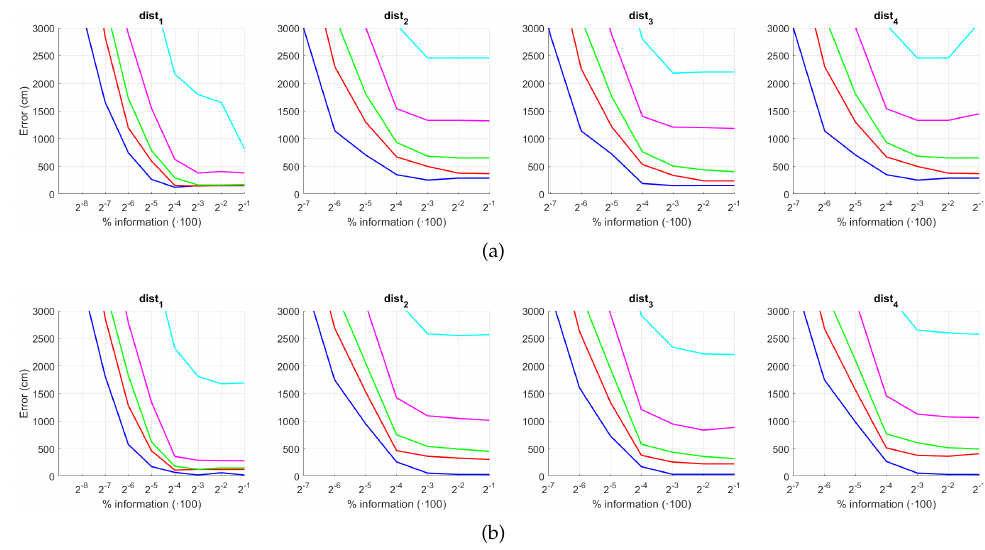
Figure 27. WS average localization error with occlusions: ( a ) no filter and ( b ) homomorphic filtering. Legend: —– Original, —– Occlusion 1, —– Occlusion 2, —– Occlusion 3, —– Occlusion 4.